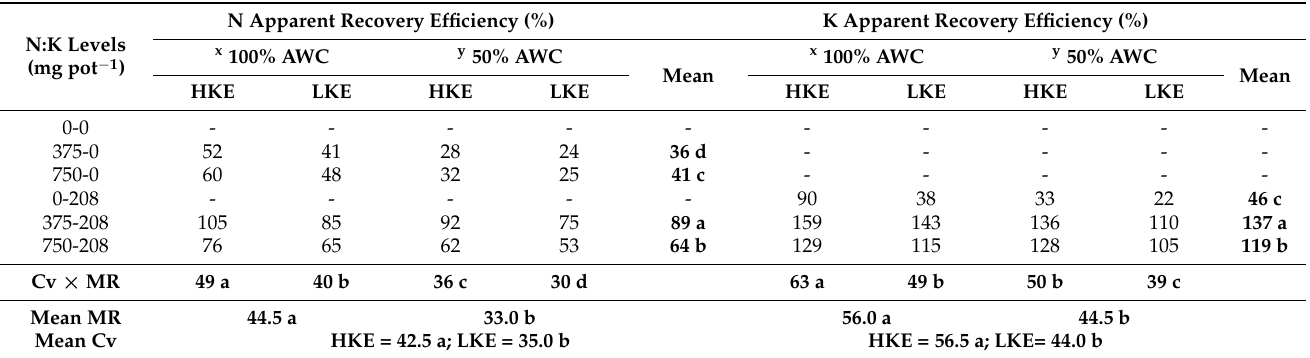
Table 4. Effect of applied N:K levels on apparent recovery efficiency in HKE and LKE cotton cultivars under varied irrigation